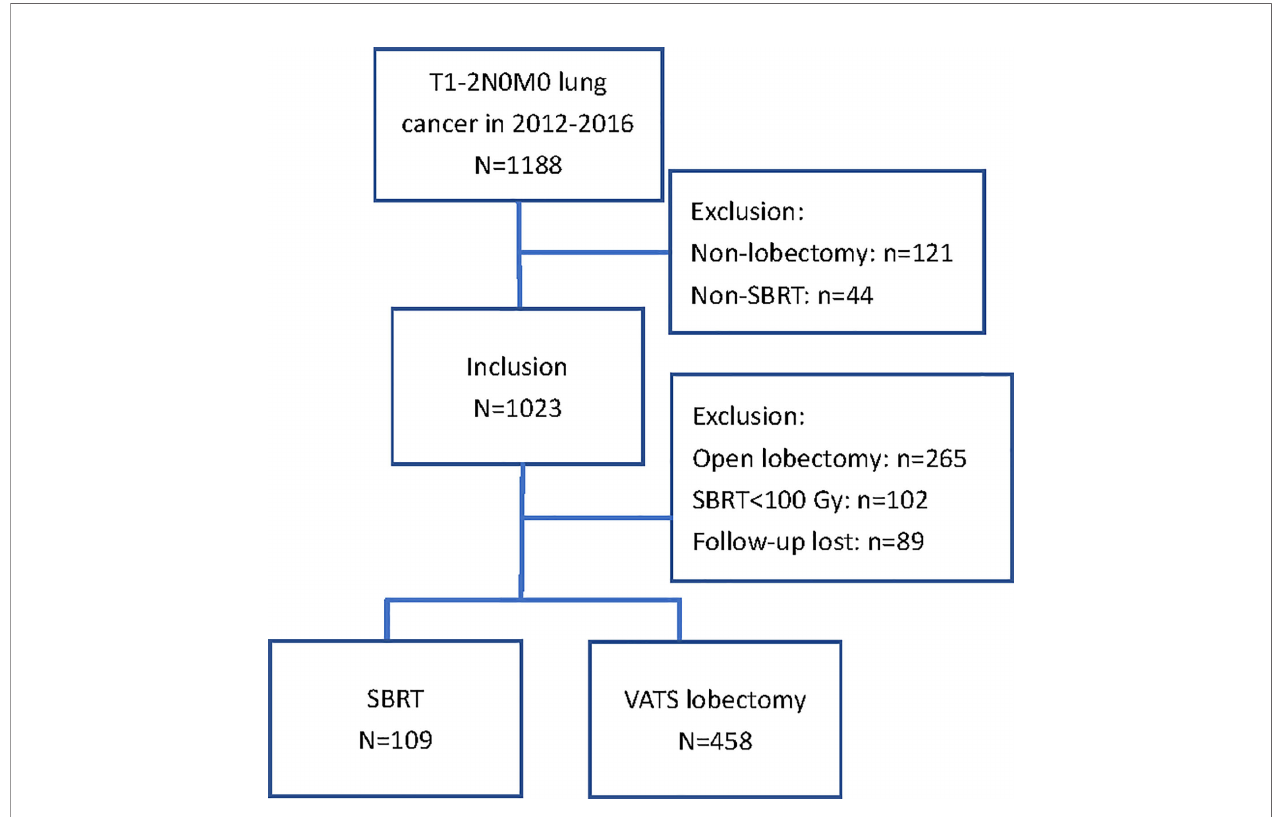
FIGURE 1 | Description of study population; inclusions and